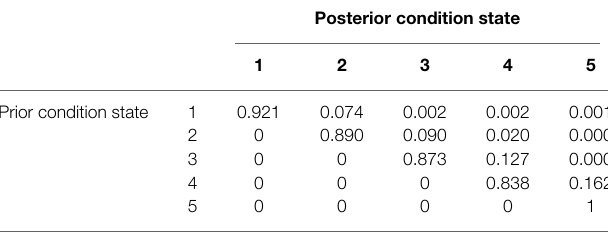
TABLE 4 | Estimated transition probabilities using state-of-the-art methodology.